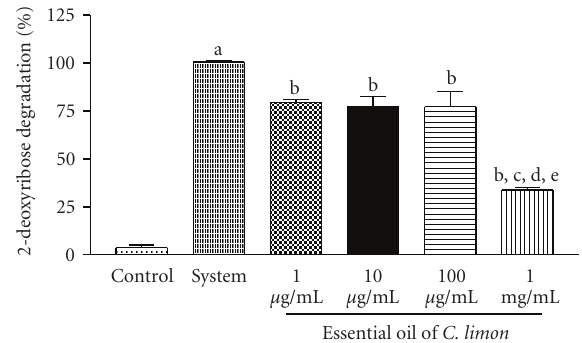
Figure 4: Hydroxyl radical scavenging activity. Hydroxyl radical scavenging activity was quantified using 2-deoxyribose oxidative degradation in vitro , which produces malondialdehyde by conden- sationwith 2-thiobarbituric acid (TBA). System isMDA production from 2-deoxyribose degradation with FeSO 4 and H 2 O 2 alone.Other groups denote MDA production by FeSO 4 and H 2 O 2 in the presence of di ff erent concentrations of EO. Bars represent mean ± SEM. Bars represent mean ± SEM. a P < . 001, when compared to control; b P < . 001, when compared to 1 μ g/mL; c P < . 001, when compared to 10 μ g/mL; d P < . 001, when compared to 100 μ g/mL; e P < . 001, when compared to 1mg/mL. One-way ANOVA followed by Tukey’s multiple comparison post hoc test was applied to all data.